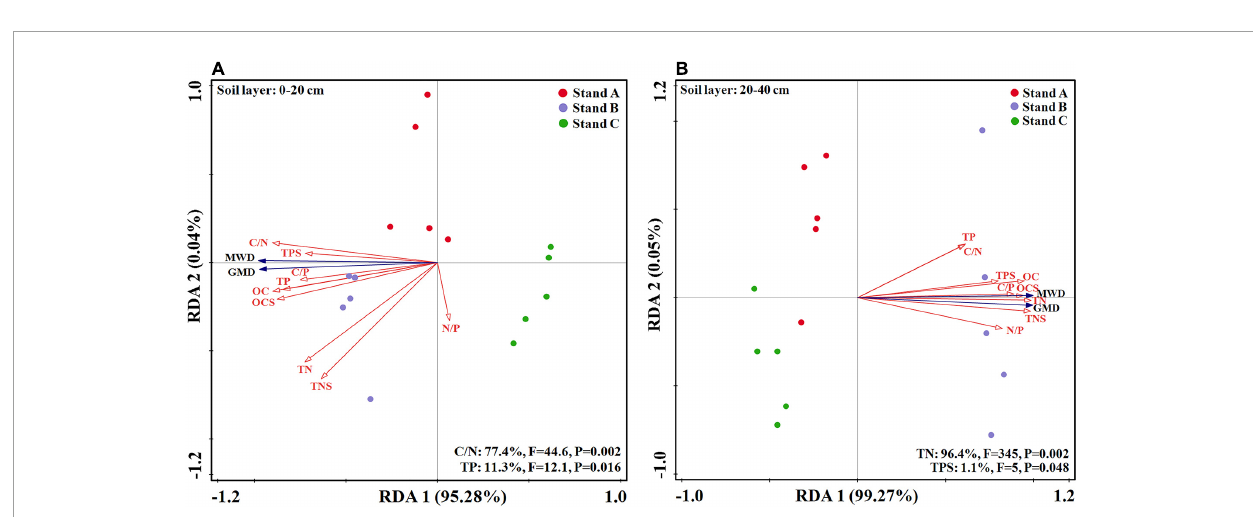
FIGURE6 Redundancy analysis of soil aggregate stability and soil ecological stoichiometric characteristics across the three stand types at 0–20 cm (A) and 20–40 cm (B) . MWD and GMD stand for mean weight diameter and geometric mean diameter, respectively. OC, TN, and TP stand for the contents of organic carbon, total nitrogen and total phosphorus in bulk soil, respectively. OCS, TNS, and TPS stand for the stocks of organic carbon, total nitrogen, and total phosphorus in bulk soil, respectively. C/N, C/P, and N/P stand for the ratios of organic carbon, total nitrogen and total phosphorus in bulk soil, respectively. The red and blue arrows stand for explanatory variable and response variable, respectively.